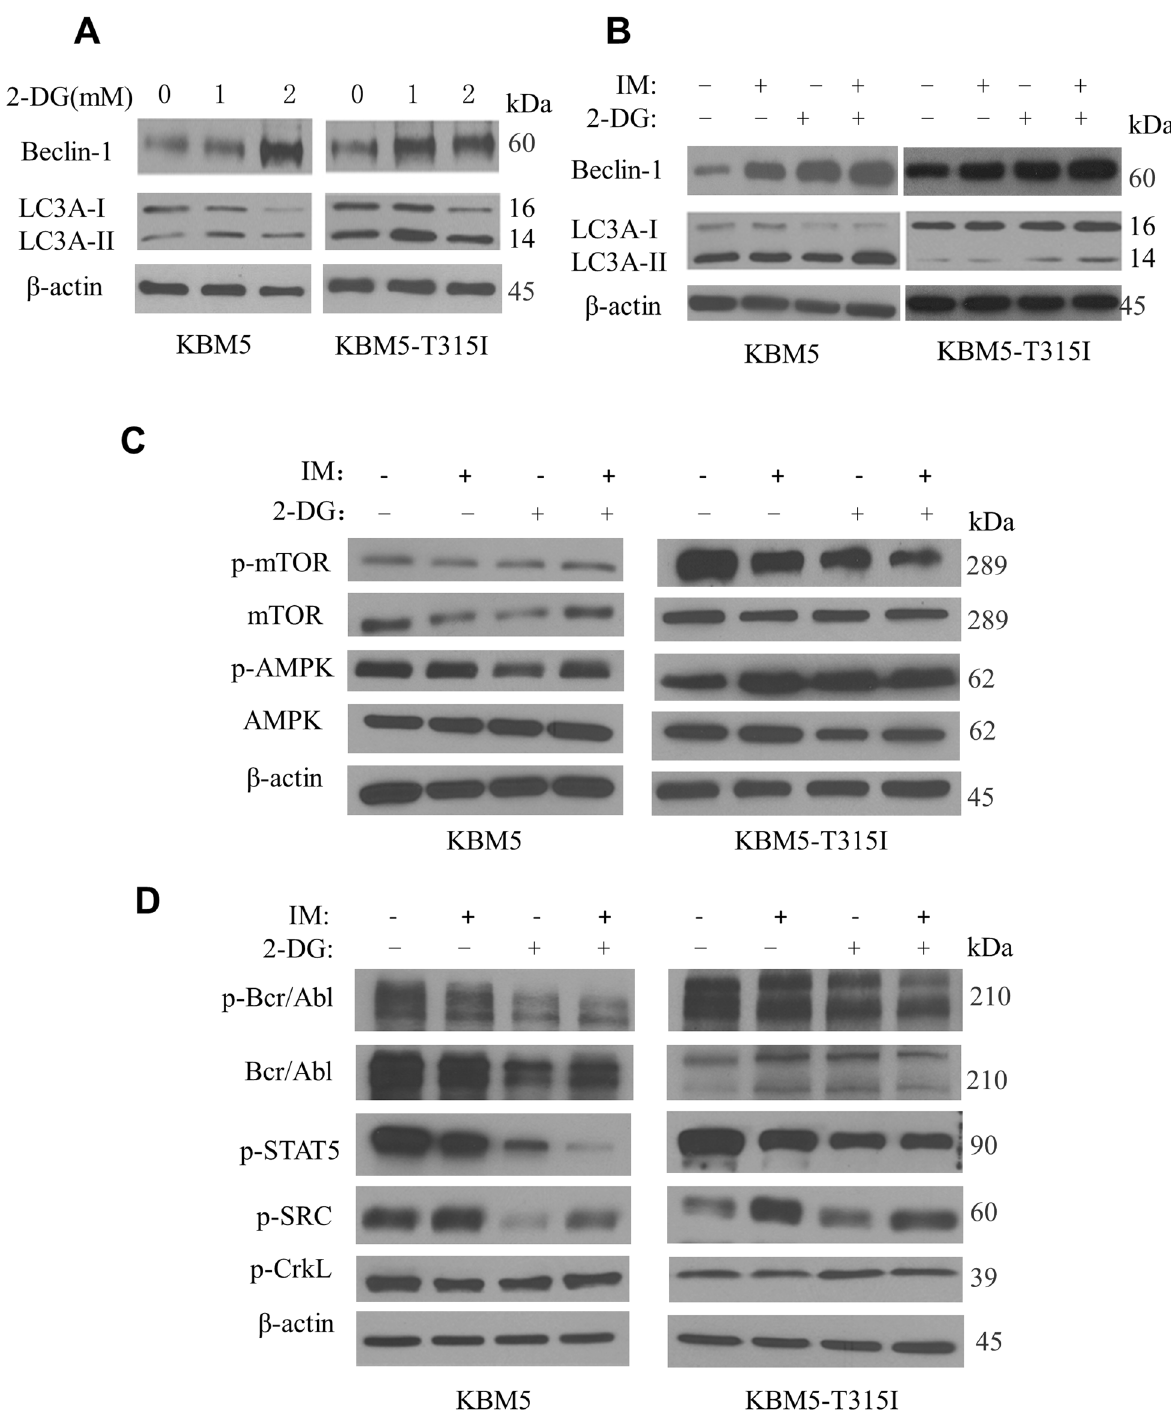
Fig. 3 2-DG in combination with imatinib induces autophagy in CML cells. A KBM5 and KBM5-T315I cells were treated with 2-DG at indicated concentrations for 48 h, and proteins were isolated for western blot analysis of beclin-1, LC3A-I/II and β -actin. B KBM5 and KBM5- T315I cells were treated with 2-DG (2 mM) and/or IM (0.1 μ M for KBM5 cells and 5 μ M for KBM5-T315I cells) for 48 h, and proteins were isolated for western blot analysis of beclin-1, LC3A-I/II and β -actin. C KBM5 and KBM5-T315I cells were treated with 2-DG (2 mM) and/or IM (0.1 μ M for KBM5 cells and 5 μ M for KBM5-T315I cells) for 48 h, and proteins were isolated for western blot analysis of p-mTOR, mTOR, p-AMPK, AMPK and β -actin. D KBM5 and KBM5-T315I cells were treated with 2-DG (2 mM) and/or IM (0.1 μ M for KBM5 cells and 5 μ M for KBM5-T315I cells) for 48 h, and proteins were isolated for western blot analysis of p-Bcr/Abl, Bcr/Abl, p-STAT5, p-SRC, p-CrkL, and β -actin.